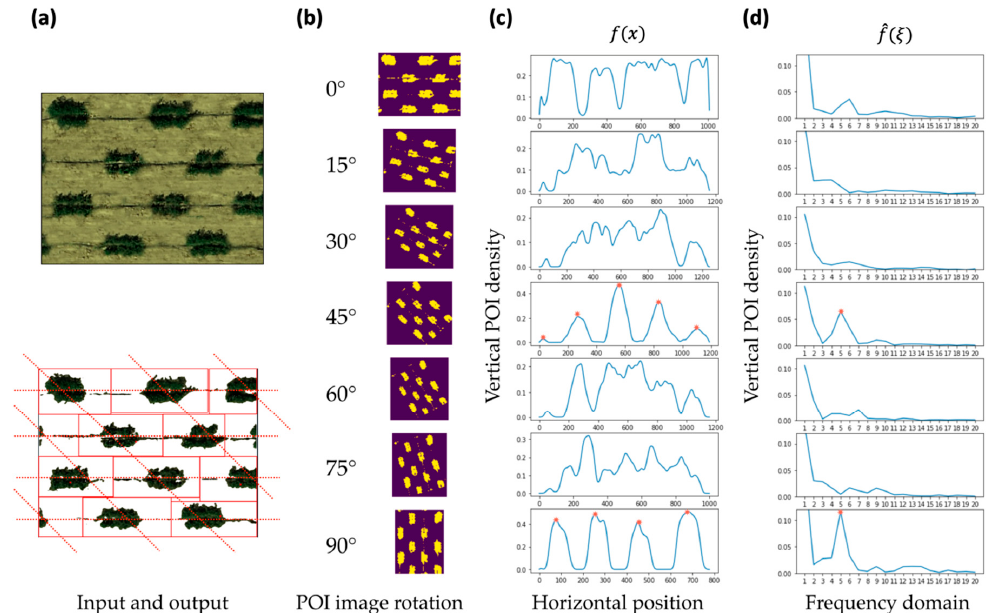
Figure 3. Automatic detection of plot layout through image rotation. The input image has a layout arranged in a rhombus shape ( a ). The rotation of the POI image is demonstrated at 15-degree intervals ( b ). Vertical-scan signal f ( x ) is an average value at the position x of the POI image, where x is the horizontal position of the POI image ( c ). Frequency domains ˆ f ( ξ ) are computed via Fourier transformation, where ξ is the signal frequency over f ( x ) ( d ). ˆ f ( ξ ) is used to determine the optimal rotation of the field image. When the correct rotation matches Fourier transformation, the frequency domain contains a single peak with a high POI density relative to other rotations. This example demonstrates that valid rotations (45 ◦ and 90 ◦ ) have repeating vertical POI density patterns that, when Fourier transformed, result in a frequency domain that can determine the optimal rotation. Red stars shown in the two optimal rotations represent the plot centroids in ( c ) and the single peaks of frequency domain (d).